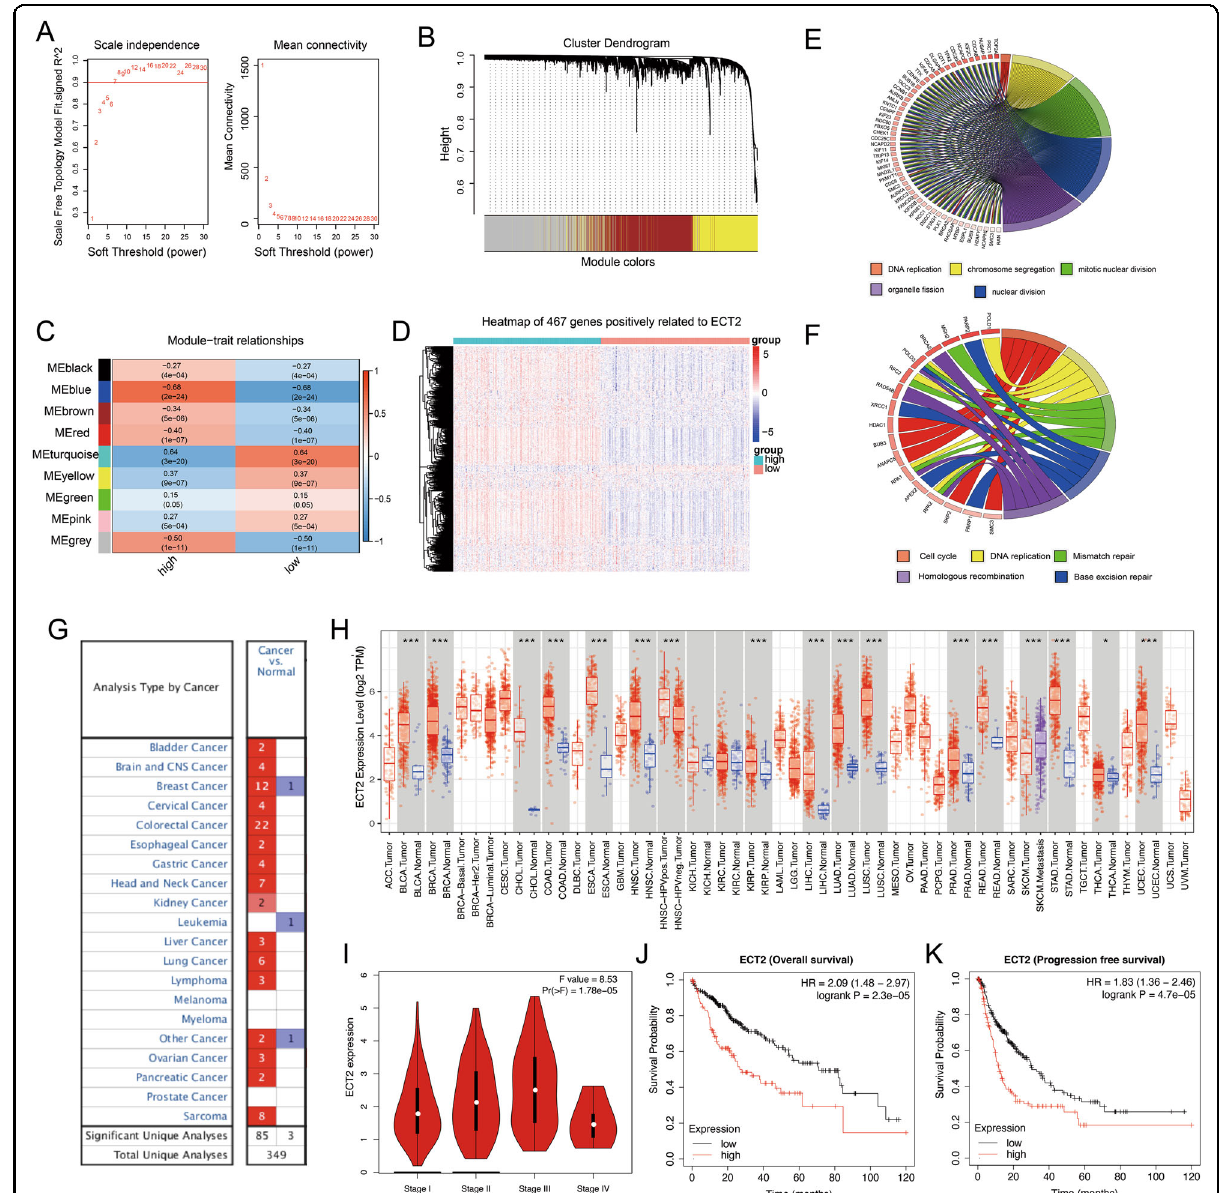
Fig. 2 Construction of ECT2-based WGCNA network and gene expression and prognosis analysis. A Optimal threshold in the WGCNA. B Heatmap of module clustering. C Diagram of the module-trait relationships of ECT2. D Heatmap of the genes co-expressed with ECT2 in the TCGA- LIHC cohort. E GO enrichment analysis of the genes co-expressed with ECT2. F KEGG enrichment analysis of the genes co-expressed with ECT2. G Expression of ECT2 in multiple tumors in the Oncomine database. Blue indicates low expression in tumor tissue relative to normal tissue, and red indicates high expression in tumor tissue relative to normal tissue. The number represents the number of corresponding studies. H Expression of ECT2 in the pan-cancer and control groups. I Correlation analysis of ECT2 and clinical stage in the GEPIA database. J OS curve of the effect of ECT2 expression in the TCGA-LIHC cohort. K PFS curve of the effect of ECT2 expression in the TCGA-LIHC